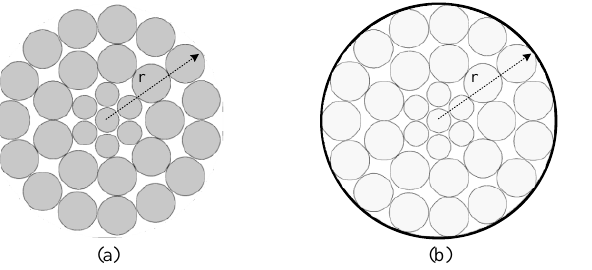
Figure 1. Schematic diagram of a single naked line, where r is the radius: ( a ) actual line; ( b ) simpli- fied line.